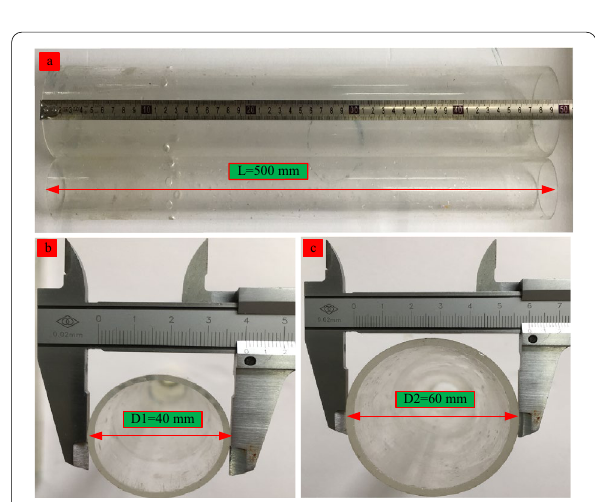
Figure 18 Size of the transparent circular